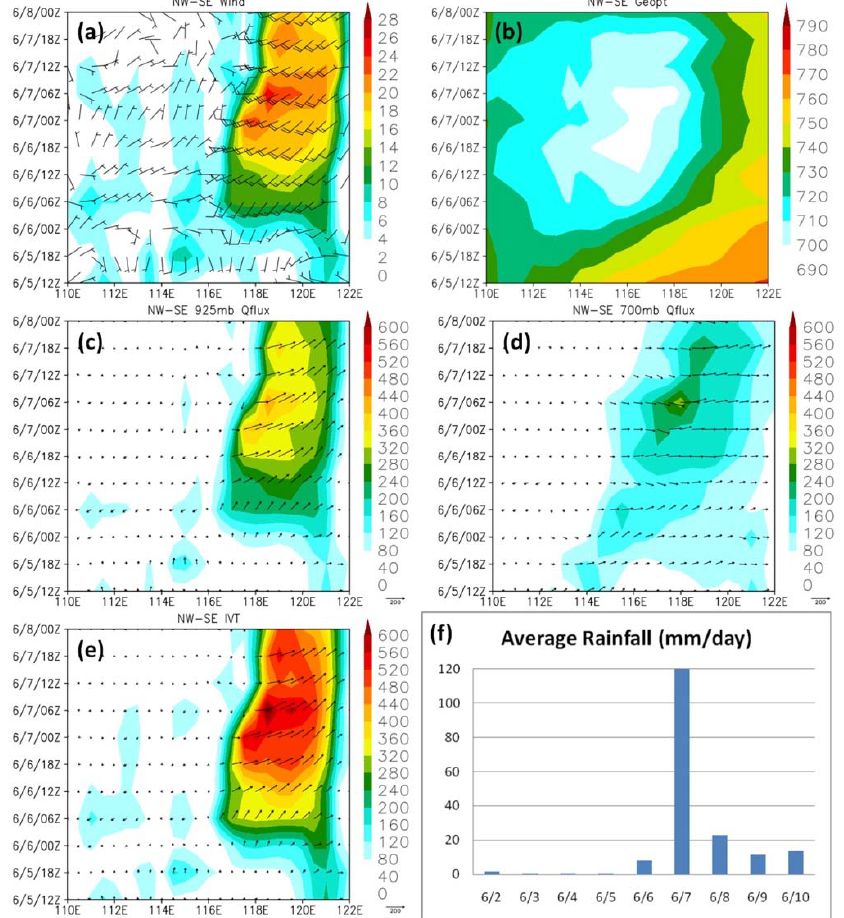
Figure 12. The CFSR Hovmöller diagram along the NW–SE line (black line in Figure 1) from 1200 UTC (2000 LT) 5 June to 0000 UTC (0800 LT) 8 June 2003: ( a ) 925 hPa winds ( V ; m s − 1 ) (a full barb and half barb represent 10 and 5 m s − 1 , respectively; ( b ) 925 hPa geopotential height (gpm); ( c ) 925 hPa horizontal moisture flux vector (qV; g kg − 1 m s − 1 ); ( d ) 700 hPa horizontal moisture flux vector (qV; g kg − 1 m s − 1 ); ( e ) integrated vapor transport (IVT; kg m − 1 s − 1 ) in the boundary layer (below 850 hPa); ( f ) time series of island ‐ scale areal ‐ averaged daily rainfall over Taiwan from rain gauges (mm) during 2–10 June (LT) 2003.